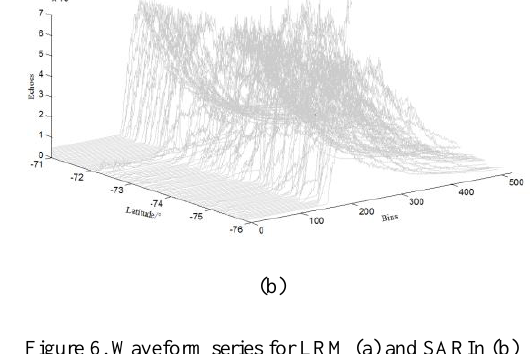
Figure 6. Waveform series for LRM (a) and SARIn